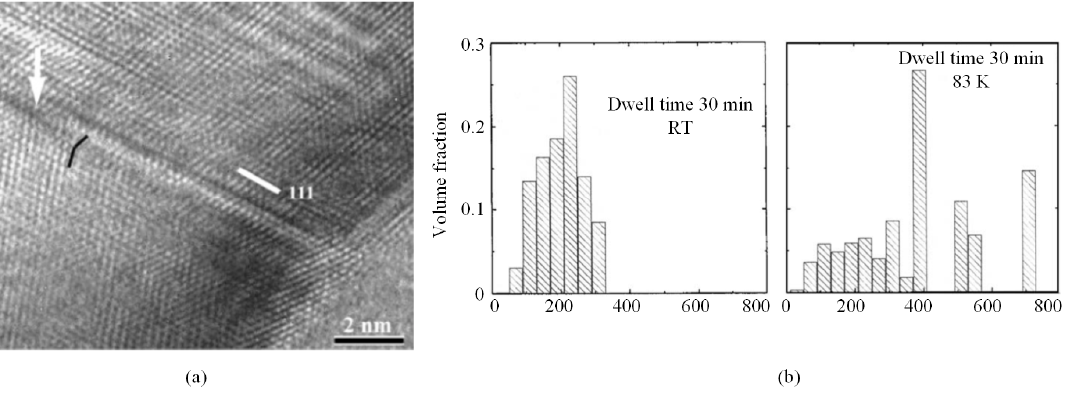
Figure 18. Low temperature indentations on copper [65]. ( a ) Twinning was observed at 77 K. ( b ) Grain size under indentation at RT and 83 K [66].